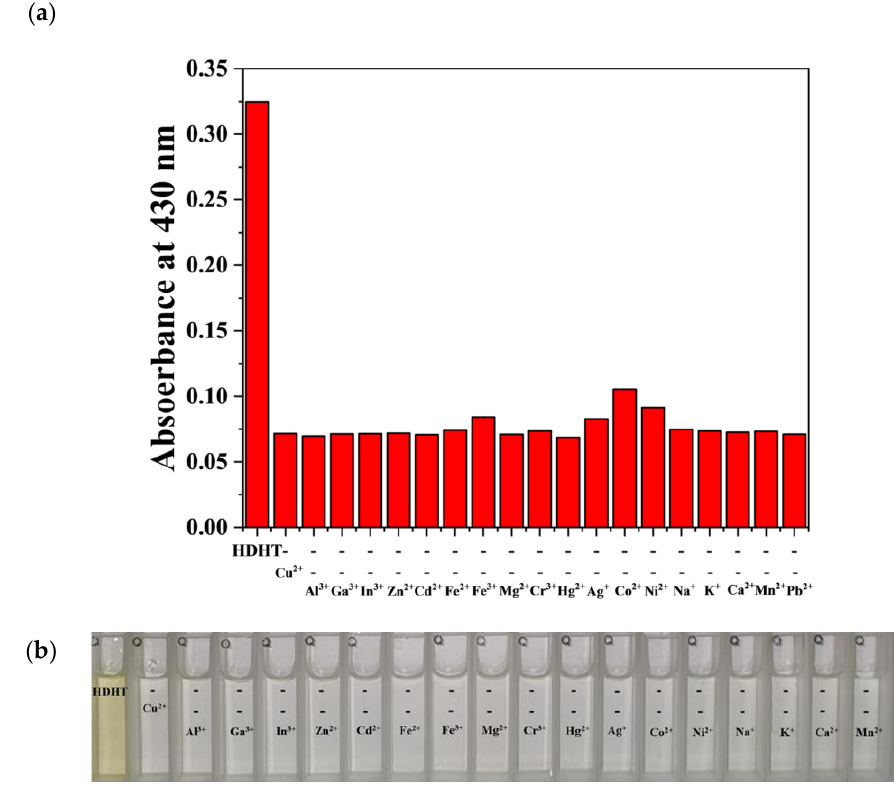
Figure 5. Inhibition test. ( a ) Absorbance of HDHT (30 μM) at 430 nm in the presence of Cu 2+ (39 μM ) and other metal ions (39 μM ). ( b ) Photograph of color changes of 30 μM HDHT solution in the presence of Cu 2+ (39 μM ) and other ions (39 μM ). Table 1. Recovery-test results for Cu 2+ in real water samples *.